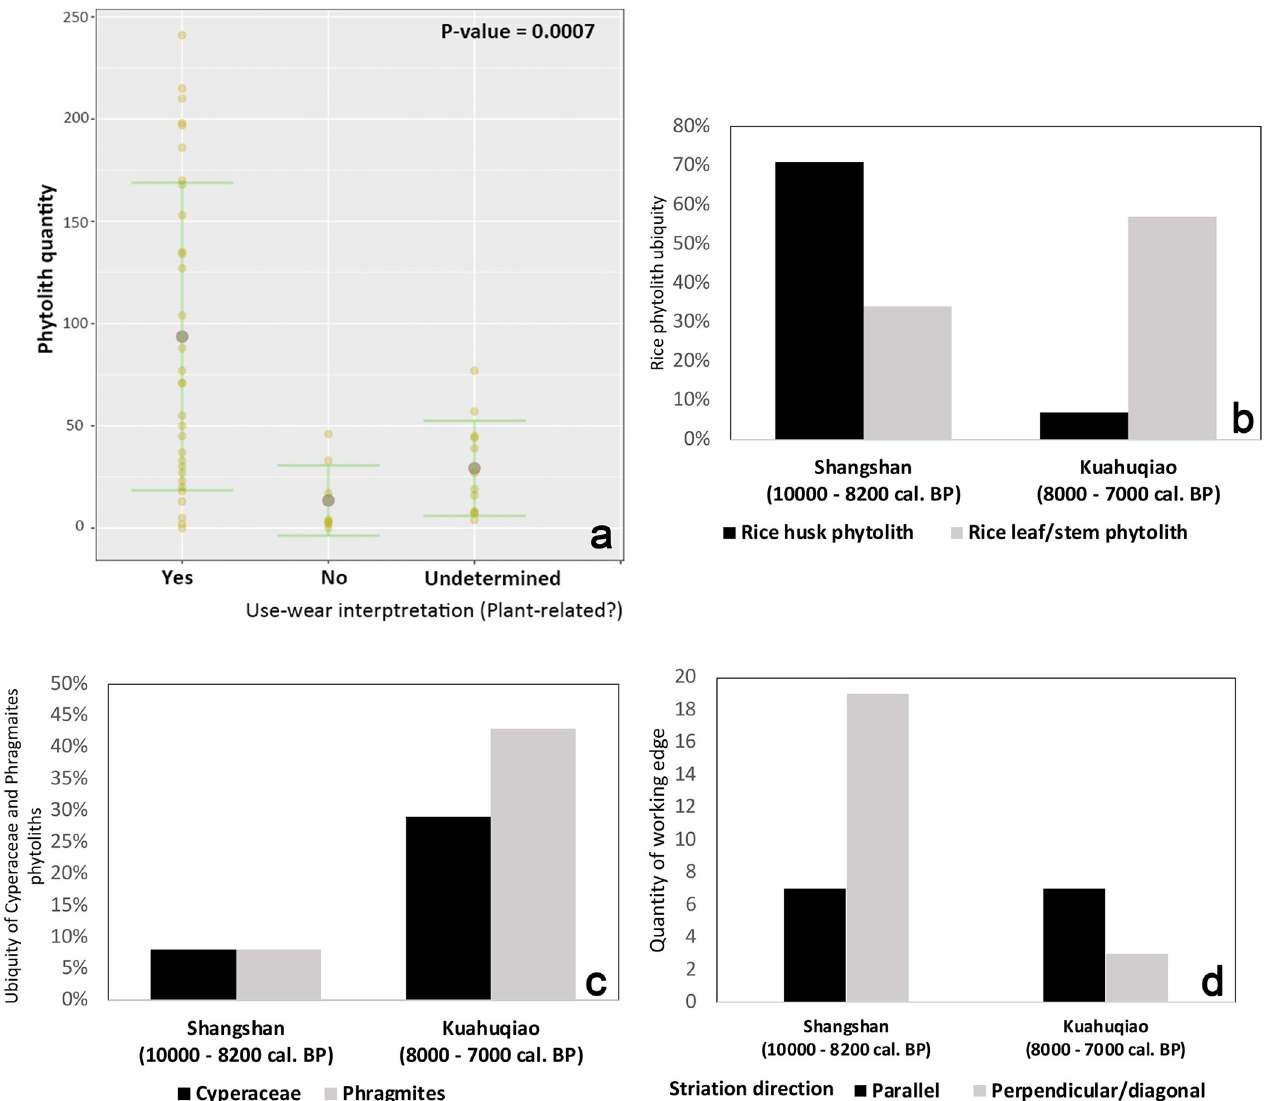
Fig 6. Statistical analyses of phytoliths and use-wear patterns from the Shangshan and Kuahuqiao flakes. (a) Results of Kruskal-Wallis analysis comparing phytolith richness and use-wear interpretation; (b) Rice phytoliths ubiquities; (c) Cyperaceae and Phragmites phytoliths ubiquities; (d) Use-wear striation alignments from the flakes with wear traces related to plant